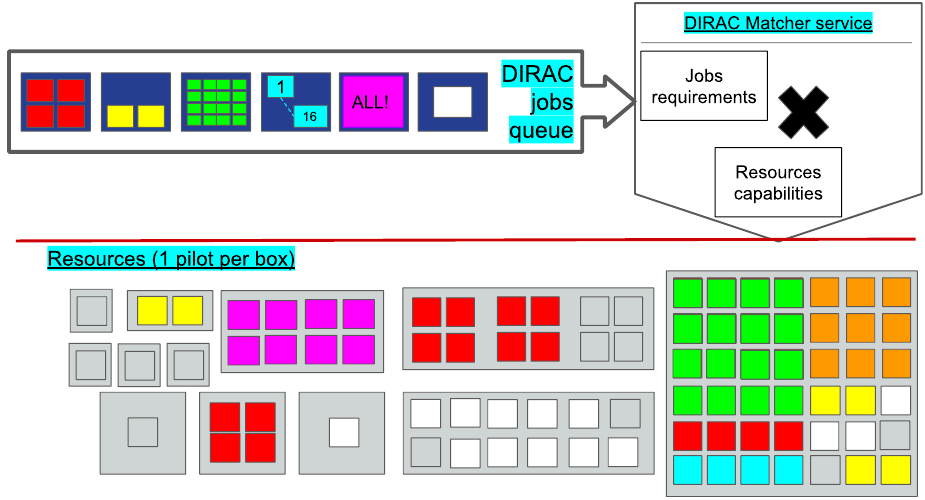
Figure 4. Job matching: matching job requirements to computing